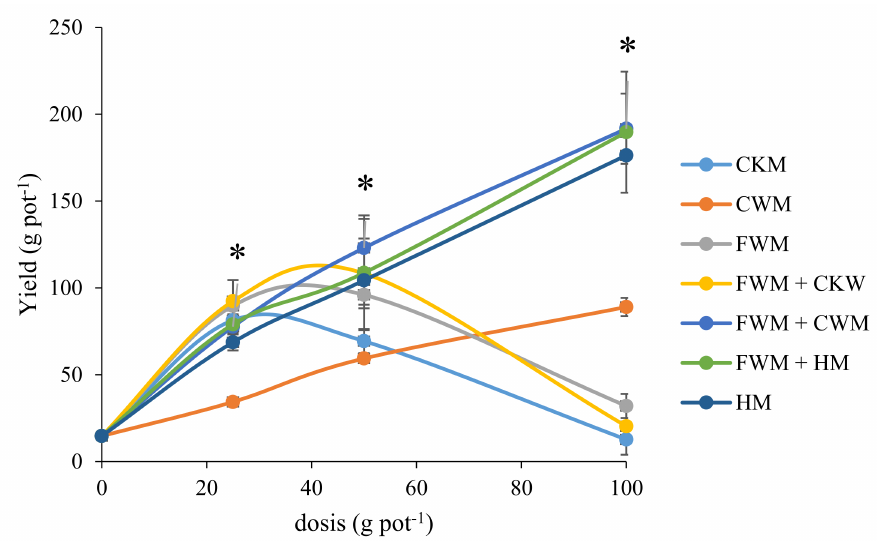
Figure 3. The Komatsuna yield affected by different dose rates and compost. HM = horse manure; CKM = chicken manure; CWM = cow manure; FWM = foot waste manure; FWM + HM = food waste manure compost combined with horse manure; FWM + CKM = food waste manure compost combined with chicken manure; and FWM + CWM = food waste manure compost combined with cow manure. * above the standard error indicates a significant difference at each dose rate based on Tukey–Kramer test ( p <